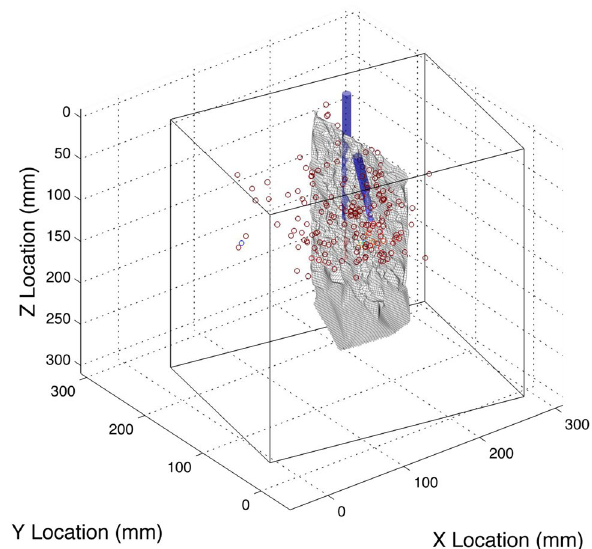
Fig. 8 Predicted hydraulic fracture from AE data. AE source loca- tions have been extensively filtered for viewing, but not for the frac- ture surface prediction procedure